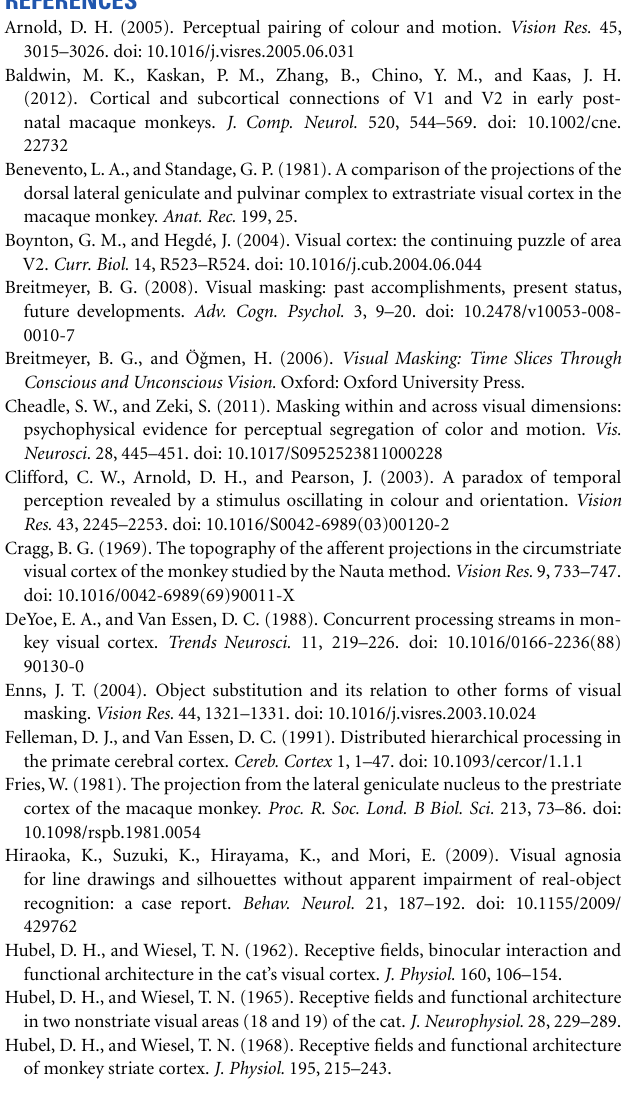
figural masking of faces: evidence for high-level interactions in face perception. Vision Res. 45,2287–2297. doi: